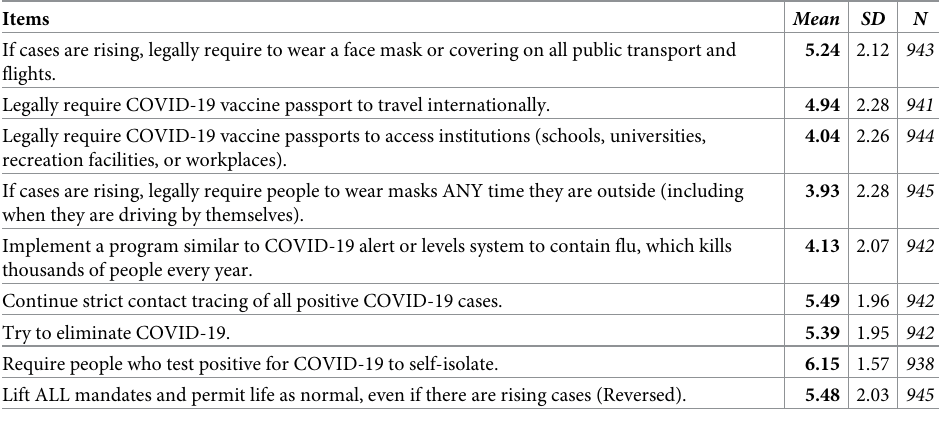
Table 3. NNP support item-based descriptive statistics and reliabilities (all